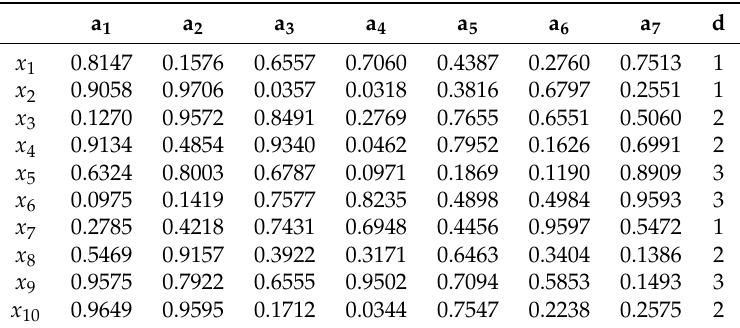
Table 1. Decision-system